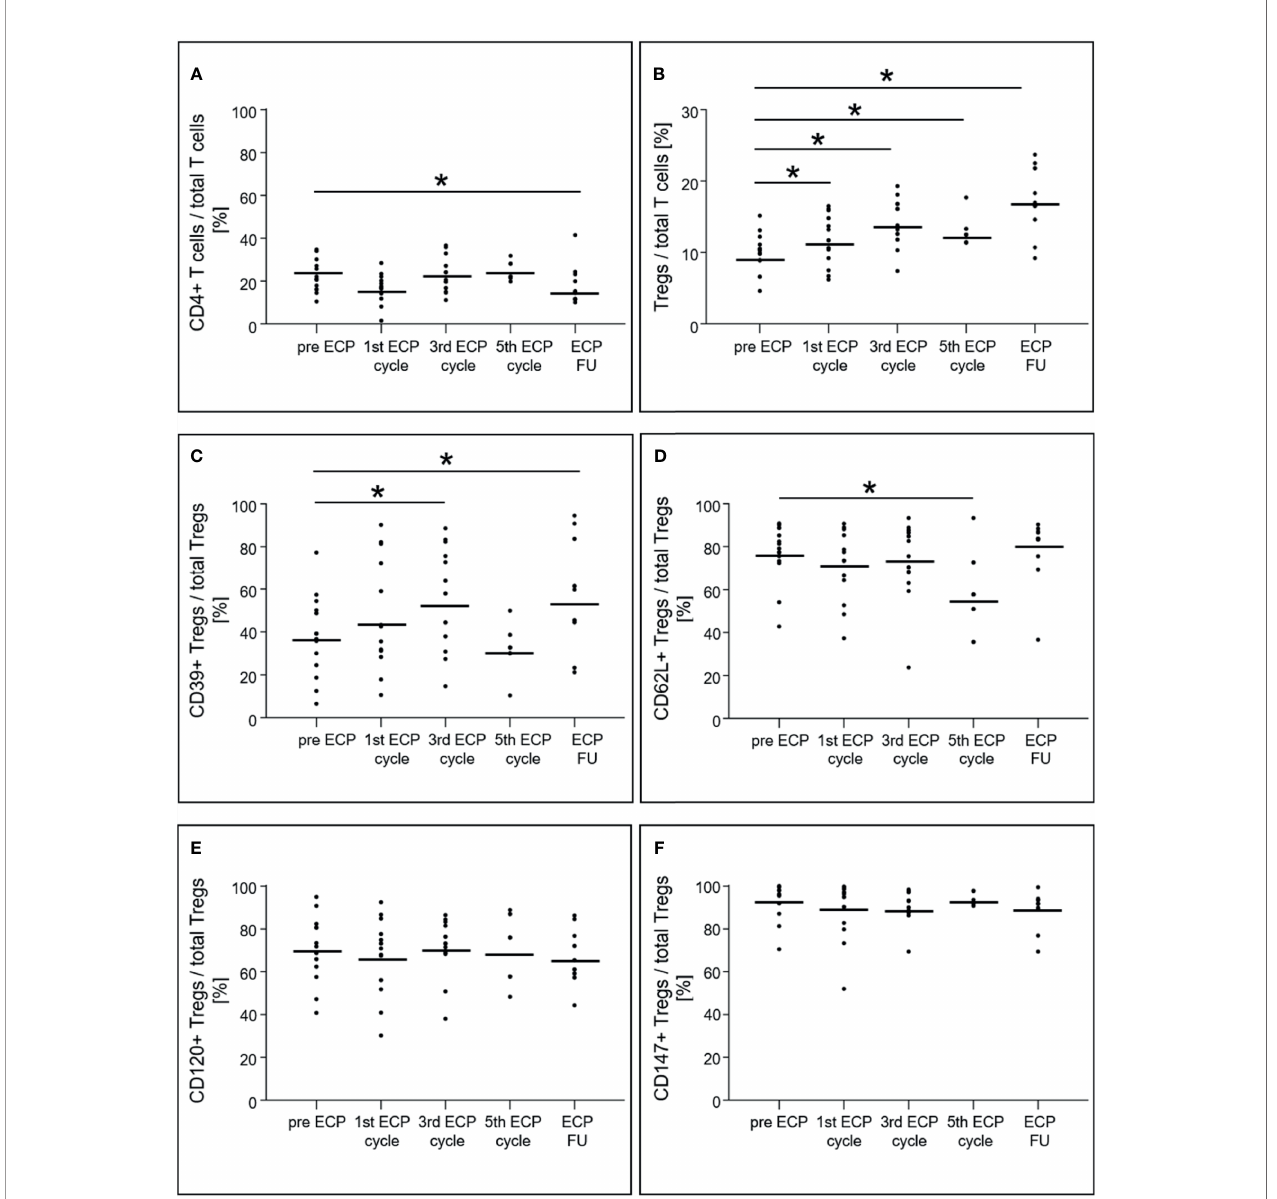
FIGURE 4 | Expression of CD4 + T cells (A) , regulatory T cells (B) and their subsets (C – F) in heart-transplanted patients receiving extracorporeal photopheresis. * marks signi fi cant differences (p ≤ 0.05); CD, cluster of differentiation; ECP, extracorporeal photopheresis; FU, follow-up; T regs , regulatory T